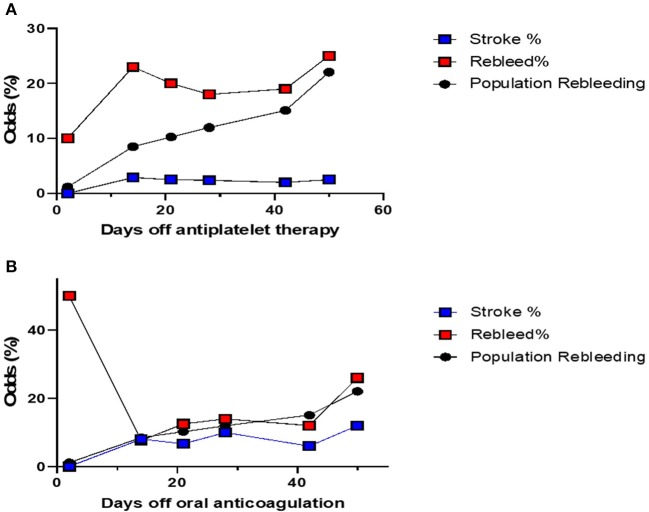
(A) The odds of stroke and recurrence in patients with cSDH on APD, compared with the risk of recurrence in patients not on any blood thinners. This risk is calculated separately for each cohort of patients depending on when their APD were resumed. The risk of recurrence is always higher depending on the duration of withholding therapy. Patients where the APD was resumed between day 2 and week 2 post-op, had the highest risk, although that risk is not significantly different from the rest. Patients who resumed their APD within 48 h had lower odds of recurrence, but this is limited by the small sample size. The odds of stroke are similar. (B) The odds of stroke and recurrence in patients with cSDH on OAC, compared with the risk of recurrence in patients not on any blood thinners. This risk is calculated separately for each cohort of patients depending on when their OAC were resumed. The risk of recurrence is highest for patients who resumed their OAC within the first 48 h. The risk of stroke increases with time. The optimal time to restart OAC would be between 2 days and 20 days post-op.